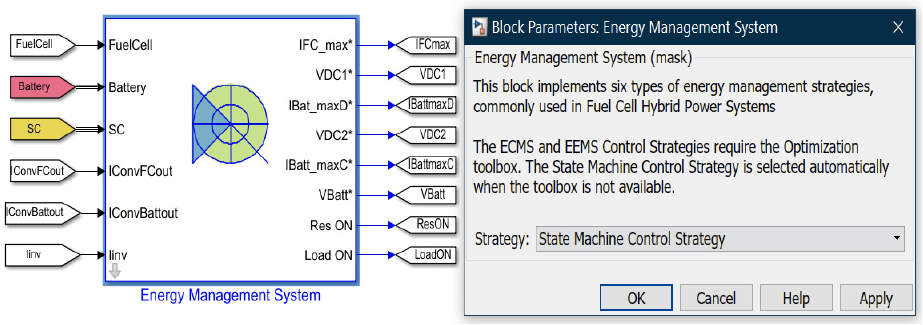
Figure 23. The EMS—state machine control strategy setup.